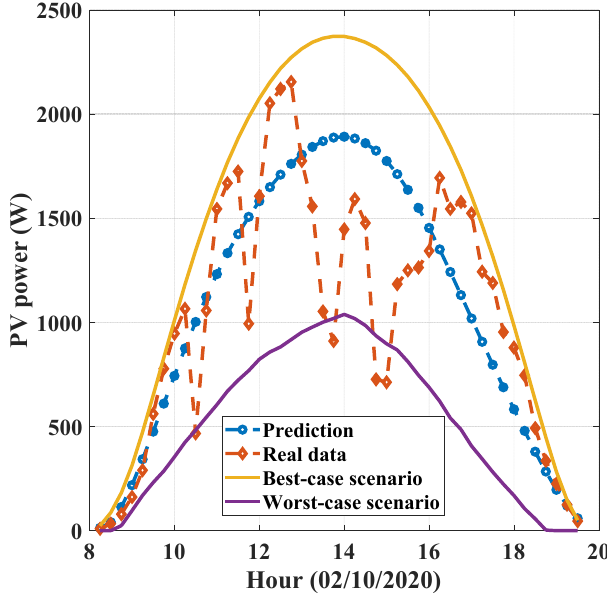
Figure 5. Prediction intervals with respect to the PV power.